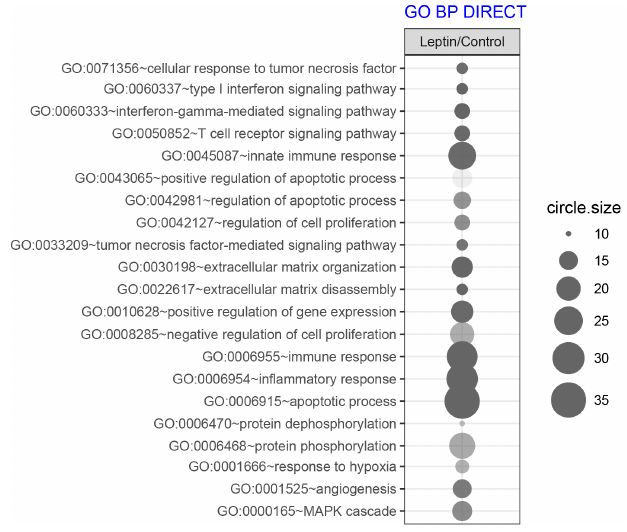
Figure 3. Bubble plot of overrepresented gene sets in DAVID GO BP DIRECT annotations database obtained from comparisons in gene expression profiles between LEP-treated LNCaP vs control. The graph show only the GO groups above the established cut-off criteria ( p with correction <0.05, a minimal number of genes per group >10). The size of each bubble reflects the number of differentially expressed genes, assigned to the GO BP terms. Transparency of the bubbles displays p -value (more transparent—closer to the border of p = 0.05).